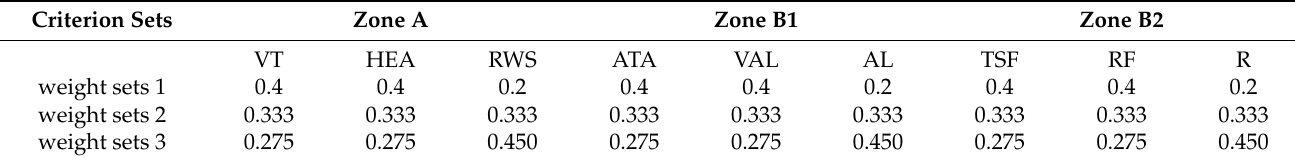
Table 2. Criterion sets and weight sets.